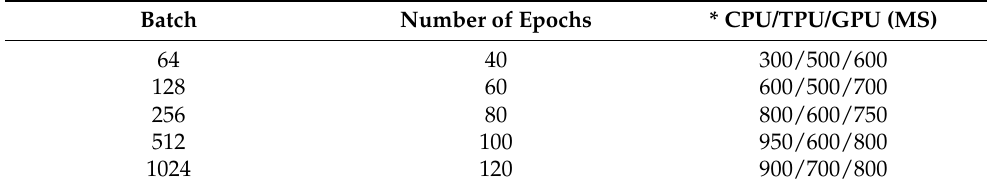
Table 7. Performance of the CPU/TPU/GPU comparisons of the proposed Mobile-HR model.